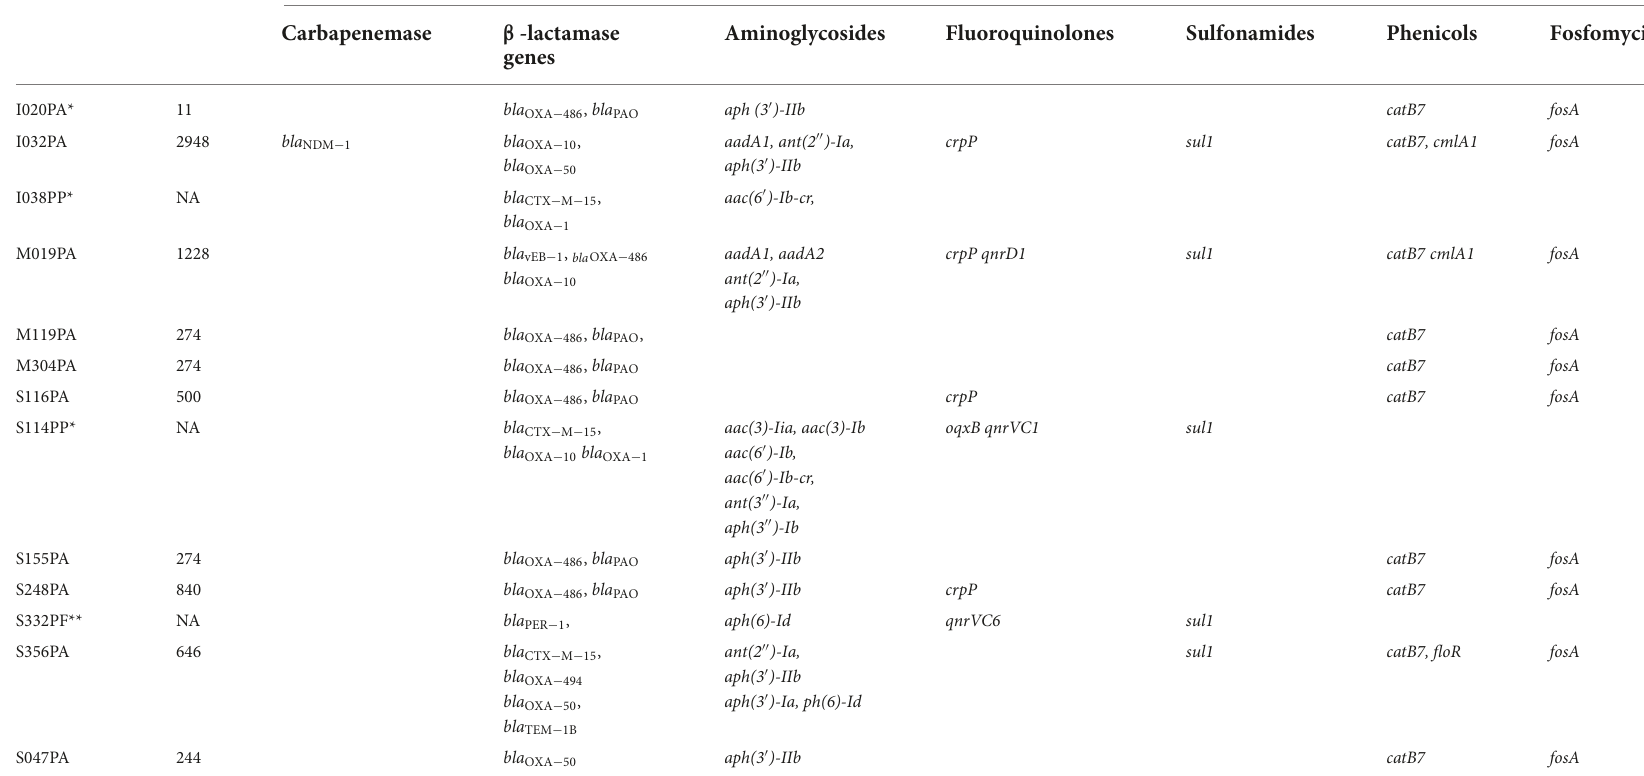
TABLE 3B Sequence types and resistance genes observed among ceftazidime-resistant Pseudomonas spp. isolated at Jimma Medical Center, Ethiopia ( n = 13). Strain